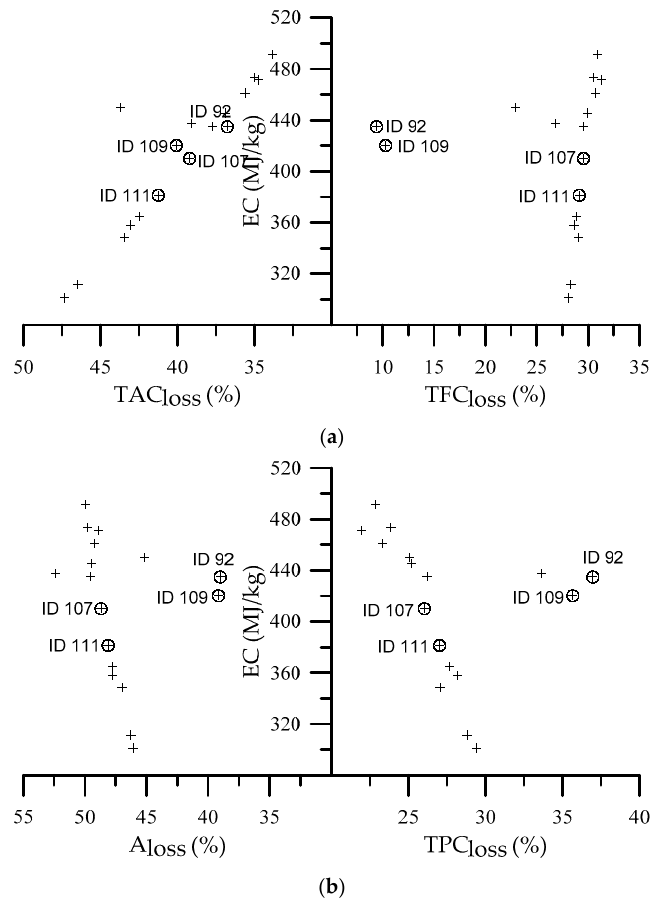
Figure 6. Pareto fronts-two-dimensional views: ( a ) EC-TAC loss -TFC loss , ( b ) EC-A loss -TPC loss ; O —the best solutions,